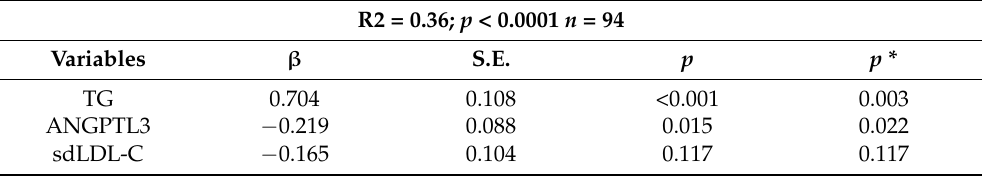
Table 5. The stepwise multiple linear regression analysis between ANGPTL8 and selected